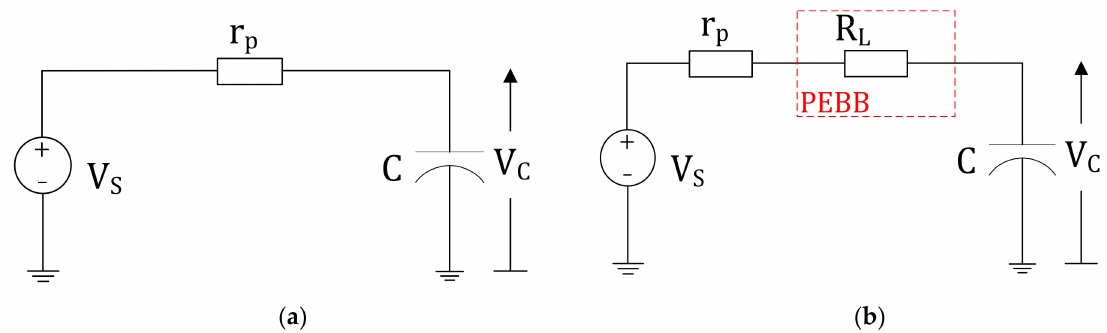
Figure 2. RC circuit leading into SCA techniques: ( a ) the basic RC circuit, ( b ) RC circuit and added useful resistance R L [54].